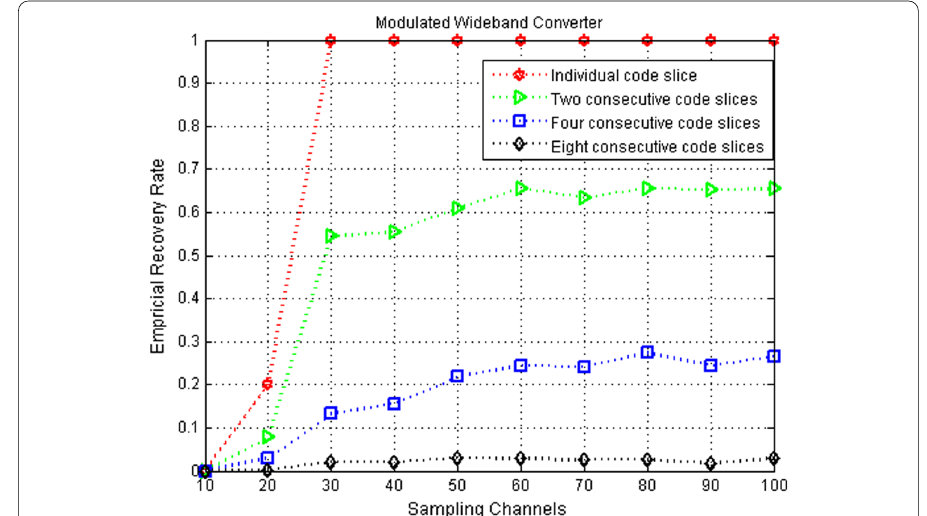
Fig. 15 Percentage of correct support recovery in MWC, when SNR